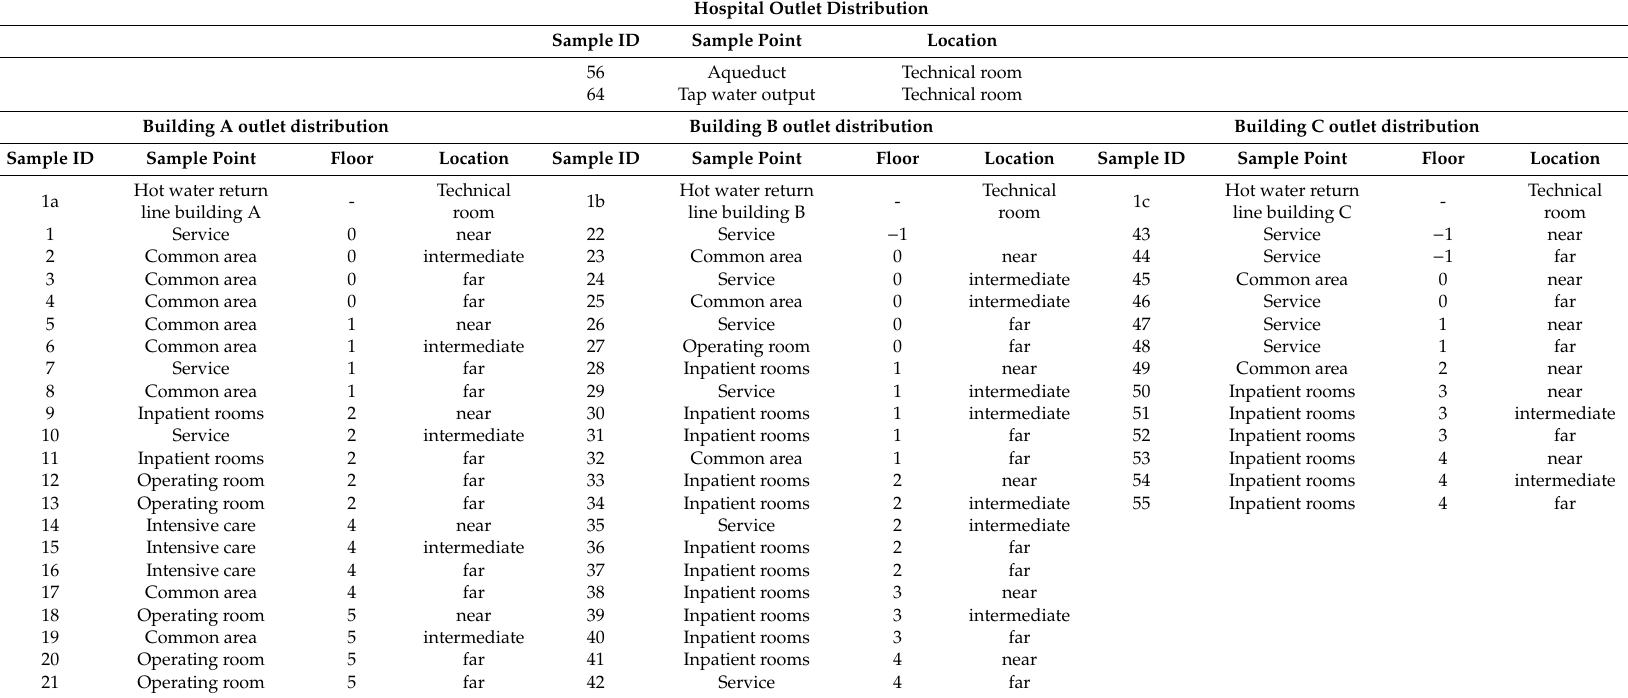
Table 1. Distribution of sampling points within buildings and in technical